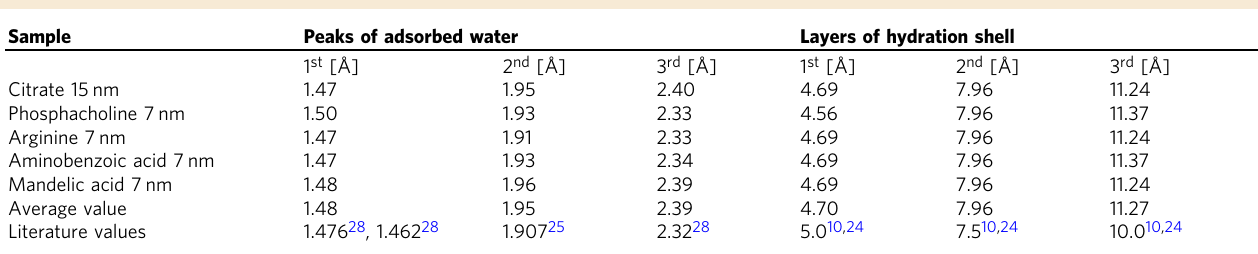
Peak positions of the fi rst three sharp peaks due to absorbed water and the fi rst three maxima of the oscillations in the hydration regime for selected samples (one capping agent of each group of SupplementaryFigure2).Theaveragevalues, calculatedfrommaximapositionsofall15investigatedsamples(seeSupplementaryTable2)areincluded forcomparison,aswellastheliteraturevaluesto which we attribute the observed peak and maxima